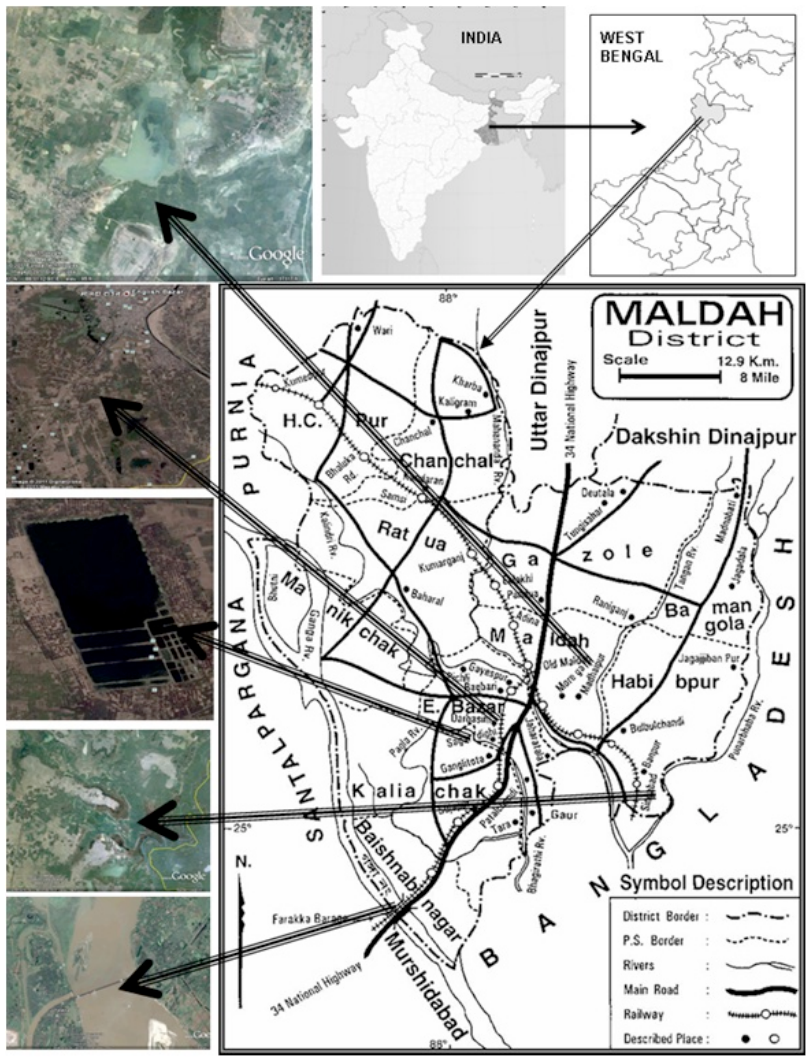
Figure 1. Location of the five wetlands under study from the Maldah District, West Bengal, India (coloured maps of five wetlands are taken from